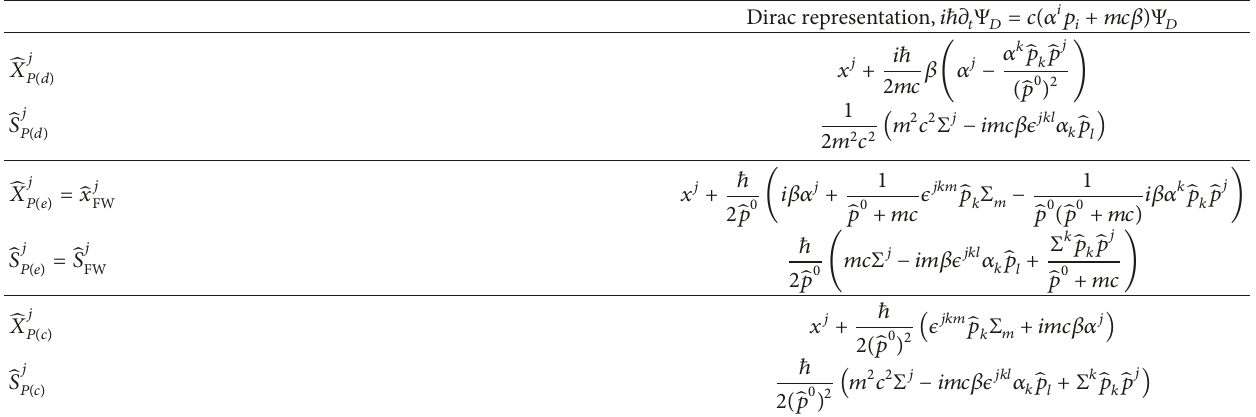
Table 3: Position/spin operators for the relativistic electron [75]. 𝛽 = ( 1 0 0 −1 ) , 𝛼 푖 = ( 0 휎